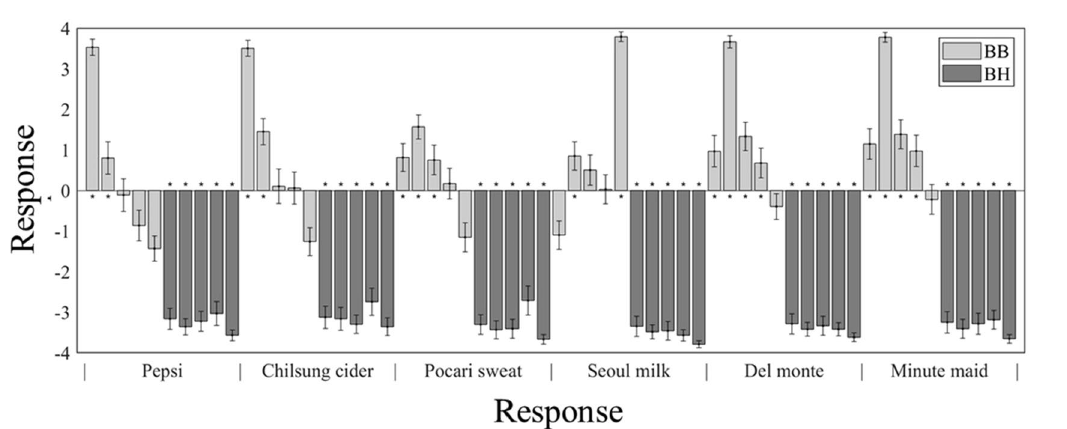
Figure 3. Mean response of acceptability toward each brand extension pair. light gray and dark gray box indicate beverage-to-beverage ( BB ) and beverage-to-household appliance ( BH ) brand extension pair stimuli (pre-determined by experimenters) each. Asterisk indicates that response to that pair were significantly far from zero (i.e., either positive or negative for BB and BH each) ( ps < 0.05). All light gray boxes were expected to show significantly high fit response (asterisk, ps < 0.05). However, there was exceptions (vacant, ps ≥